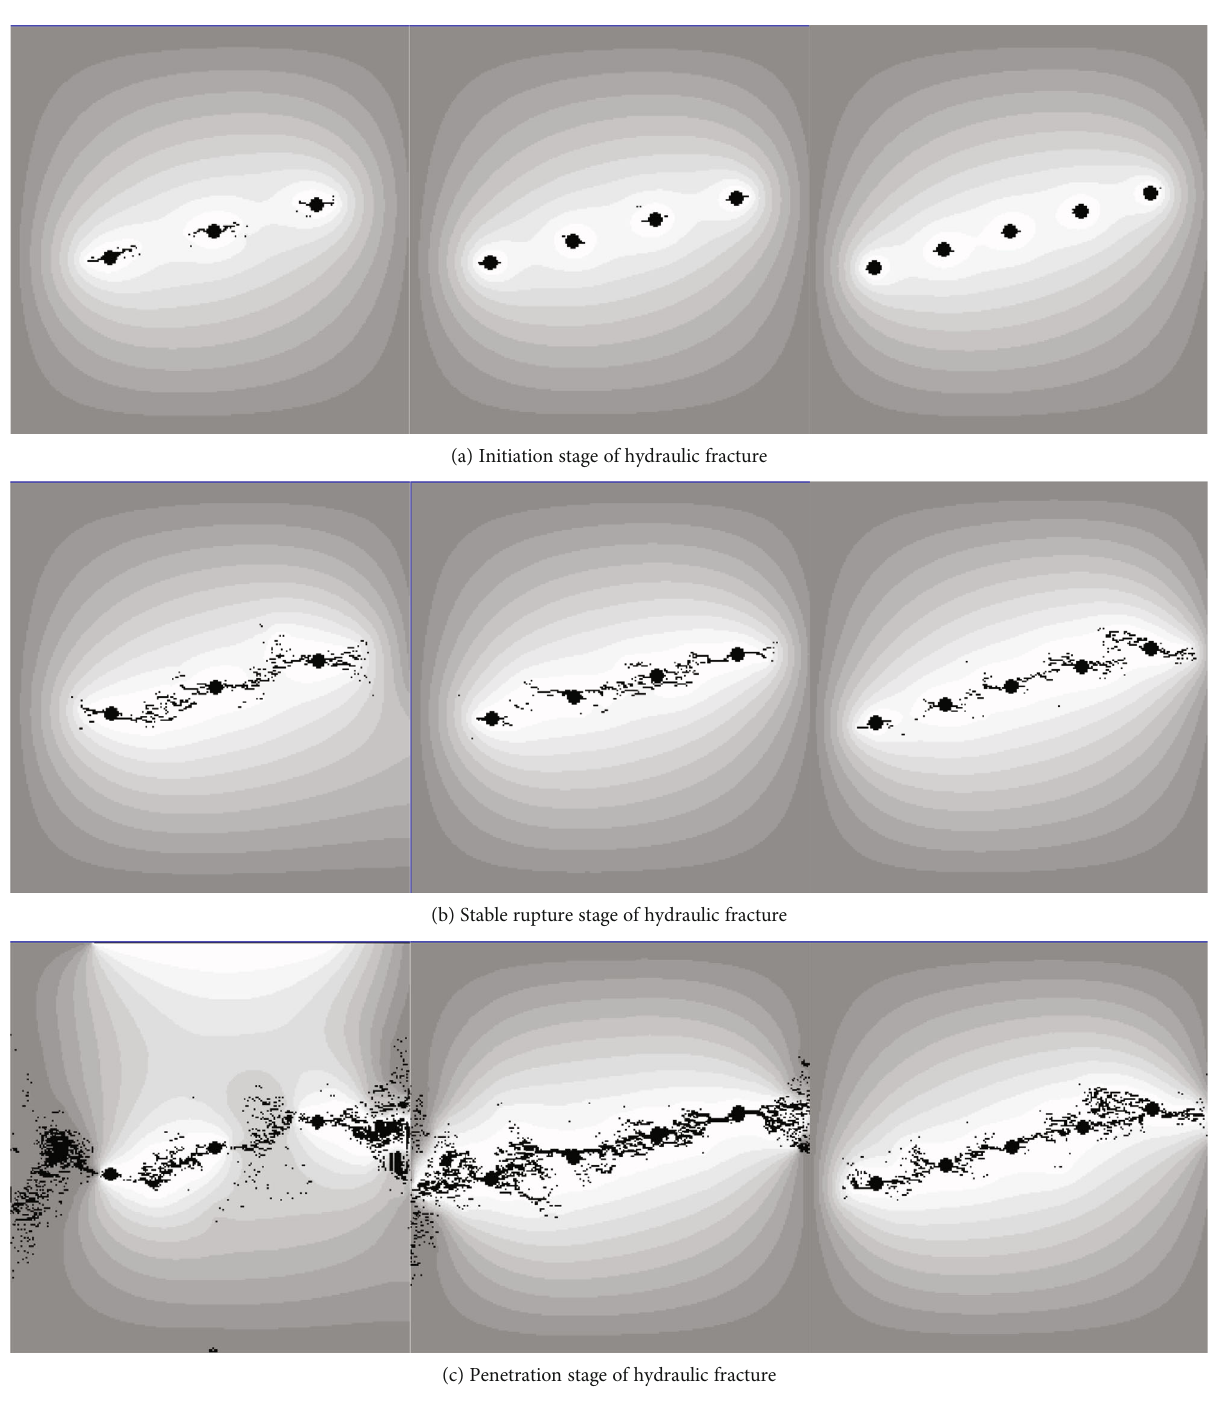
Figure 6: Initiation, propagation, and penetration process of multihole linear codirectional fractures at di ff erent densities of borehole: n = 3 , n = 4 , and n = 5